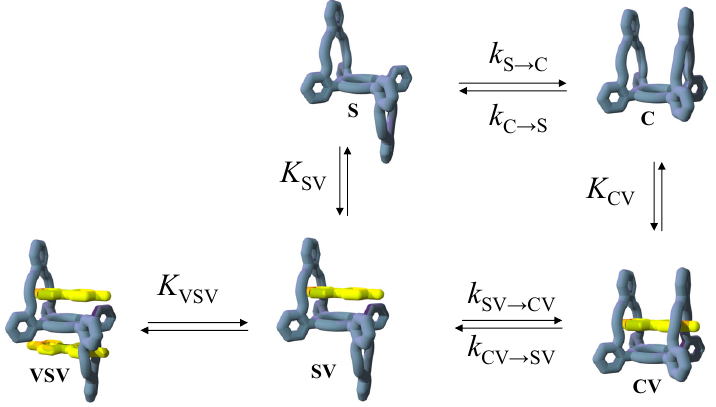
Figure 8. Binding scheme of the isomerization between S and C in the presence of V1 .